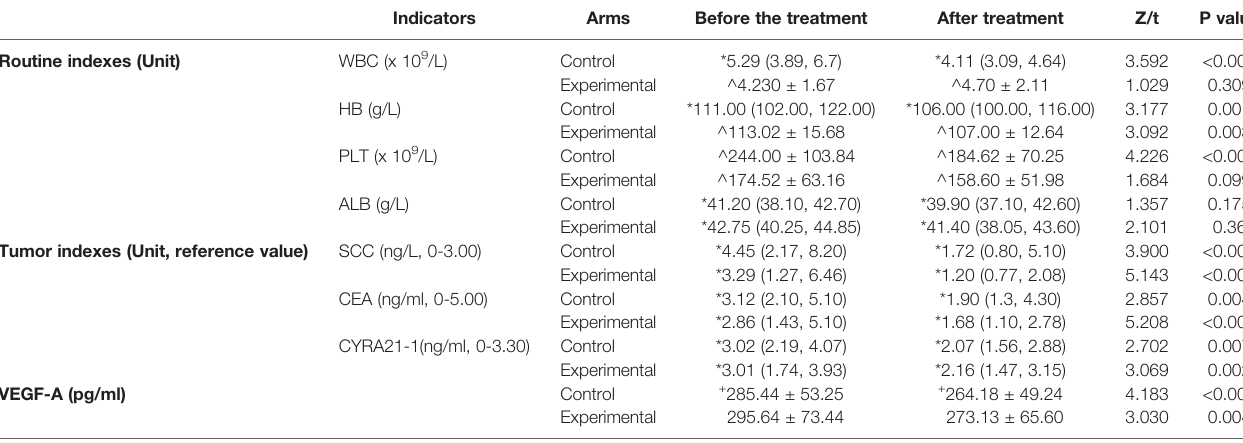
TABLE 5 | Comparison of blood indicators and VEGF-A between the two groups before and after treatment. Indicators Arms Before the treatment After treatment Z/t P value Routine indexes